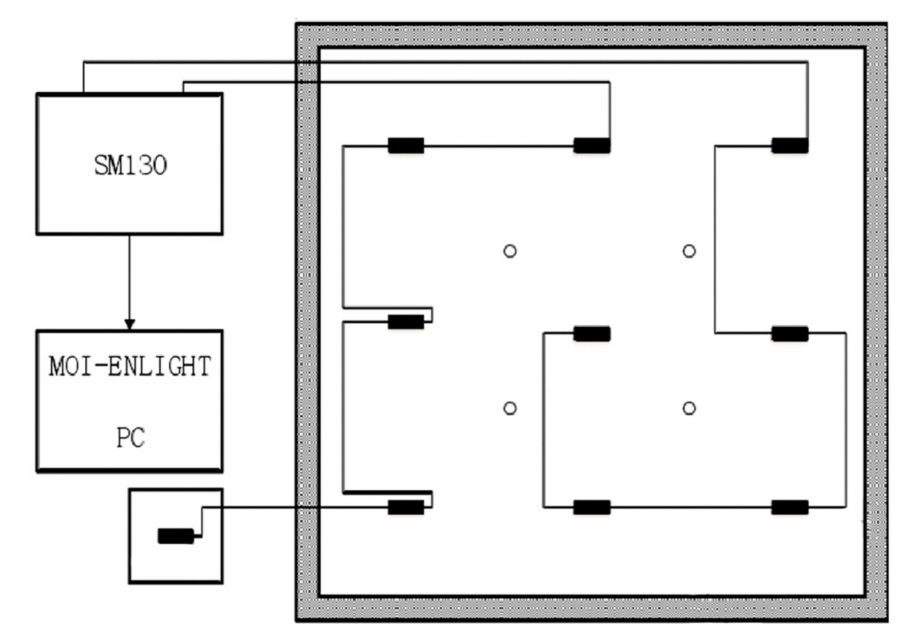
Figure 2. Diagram of the measurement system and the sensor layout.